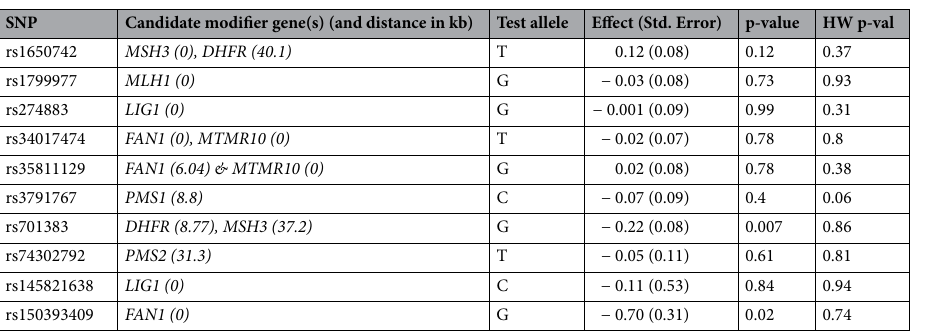
Table 3. Correlation between SNPs associated with different repair genes and allele